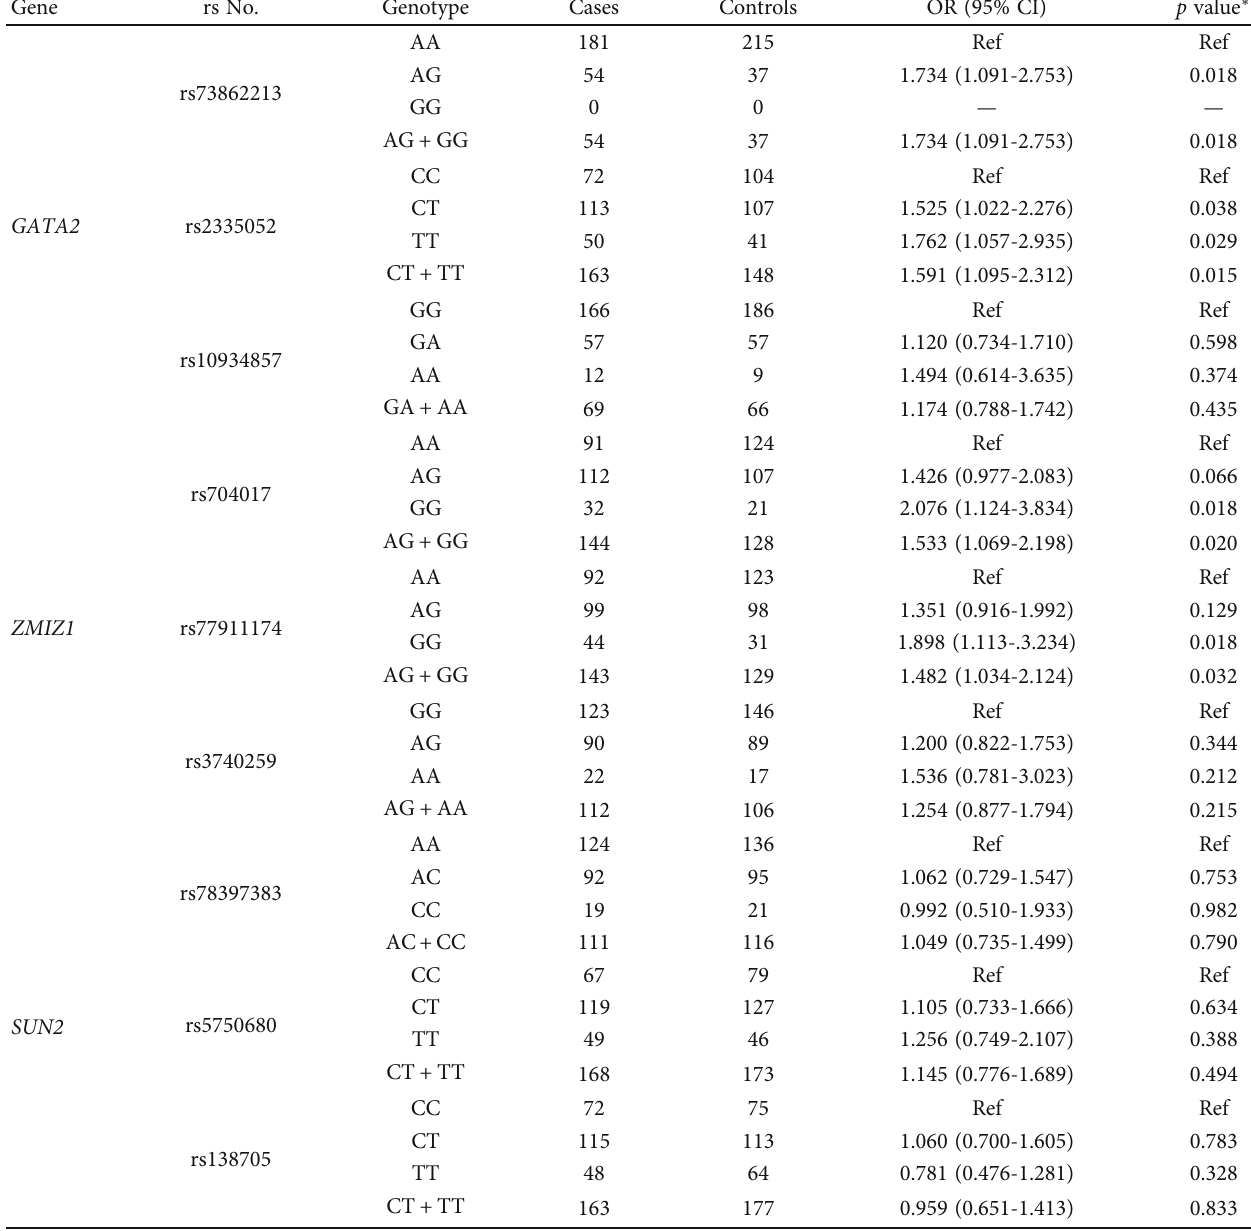
Table 3: Genotype distribution of SNPs in case and control